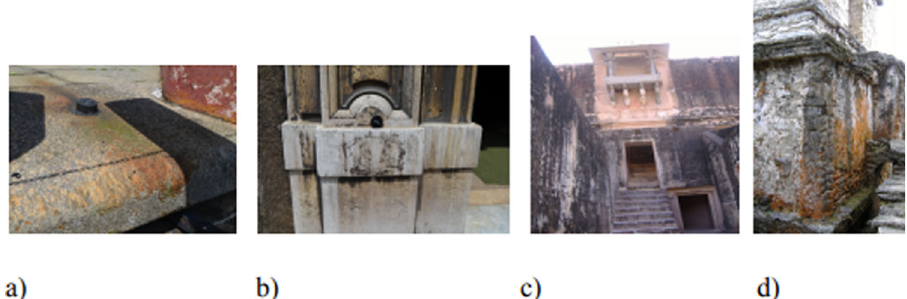
Fig. 1 Microbial discolouration of stone. Colours developed on stone surfaces by microbial colonisation. a Red and green growth of the alga Trentepohlia on gneiss; the orange/red coloration on the curved area indicates intracellular carotenoid droplets, possibly protecting the cells from lack of moisture or overexposure to sunlight. b Grey and light brown discoloration caused by cyanobacteria and fungal growth on limestone doorway of a church in Rio de Janeiro, Brazil. c Thick grey cyanobacterial and fungal bio fi lms on Amber fort, Rajasthan, India. The pink stone is the original colour of the sandstone. d Grey cyanobacteria-dominated bio fi lms next to red/brown growth of the alga, Trentepohlia , on the base of the limestone tower of the Palace, Palenque, Chiapas,